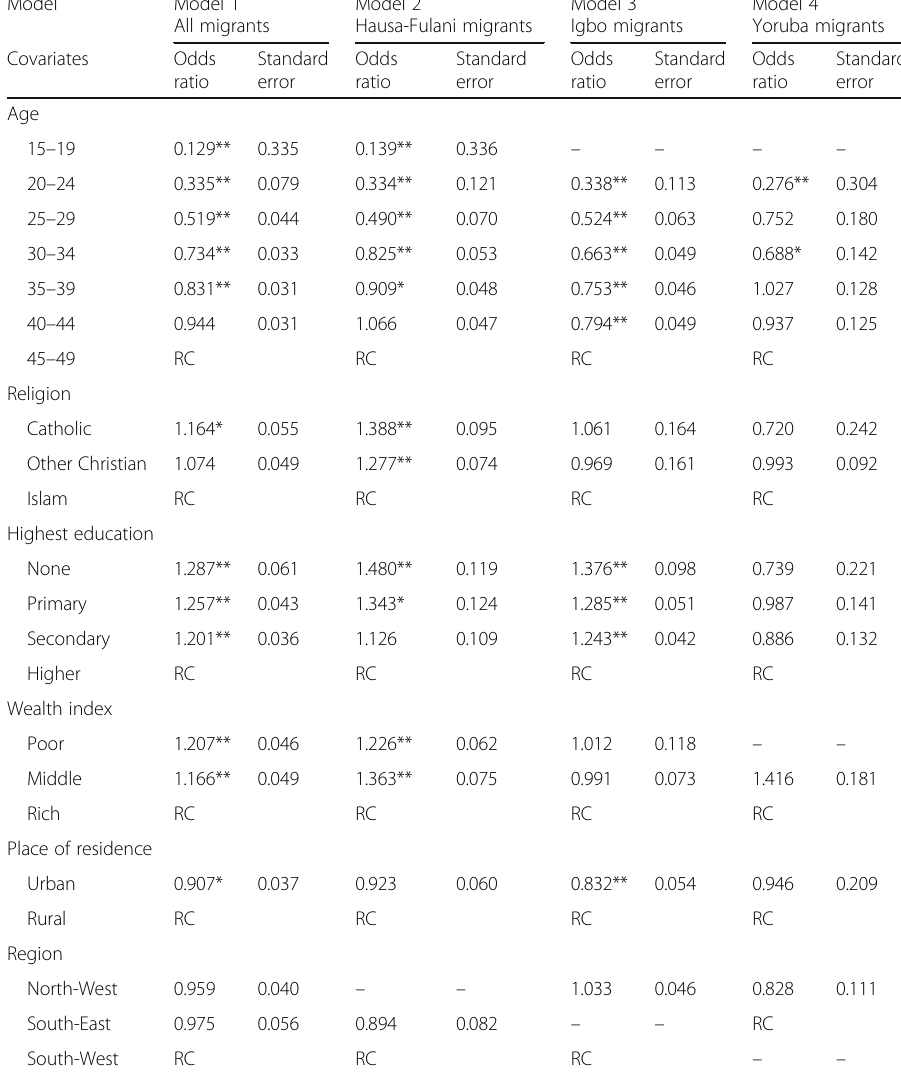
Table 4 Poisson regression model summary